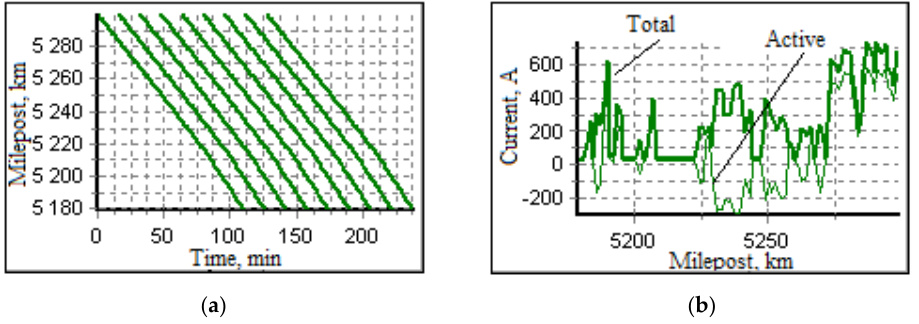
Figure 5. ( a ) Distance - time graph and ( b ) current profile of the train.